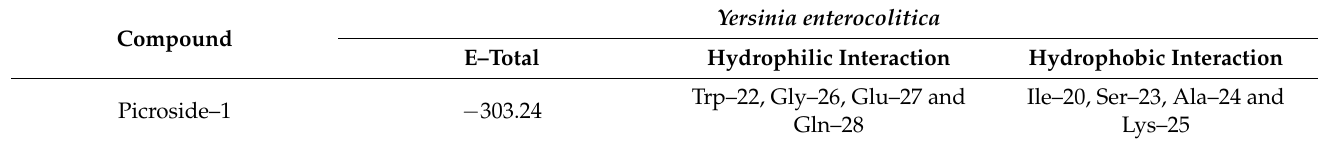
Table 5. Total estimated energy and the hydrophilic and hydrophobic interaction between the protein and